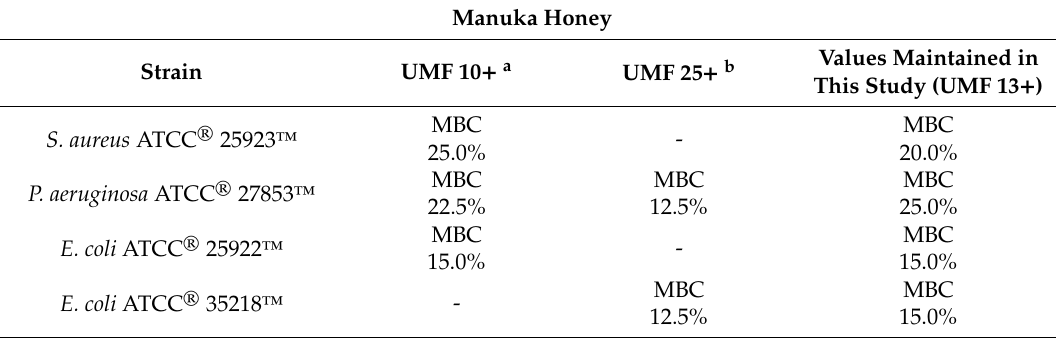
Table 4. Manuka honey minimal inhibitory concentration (MIC) and MBC values obtained for selected bacteria based on literature review and own research.